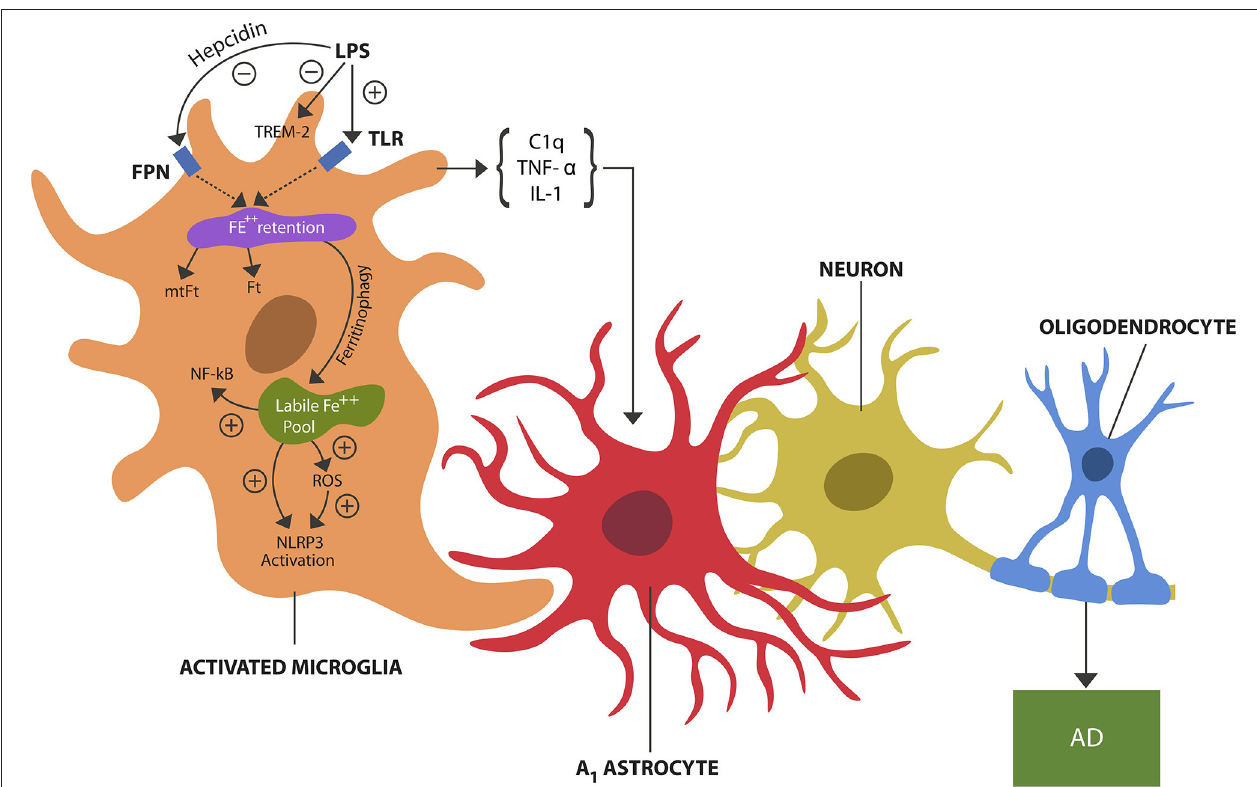
FIGURE 1 | LPS, a danger signal, binds to TLRs of microglia, inducing pathogen-mediated intracellular iron sequestration. LPS also promotes astrocytic hepcidin synthesis which via FPN prevents iron egress. In addition, LPS inhibits TREM-2 expressed on microglial cells. Intracellular iron is stored in Ft and mtFt. Iron can dissociate from ferritins via ferritinophagy, augmenting the free iron (labile iron pool). Unbound iron directly and indirectly (via ROS) activates NLRP3 and NF-kB, inducing microglial activation (training). Microglial release of cytokines, including TNF-alpha, IL-1, and C1q induces A1 astrocytes shown to engage in the phagocytosis of viable neurons and oligodendrocytes, contributing to neuronal loss and possibly